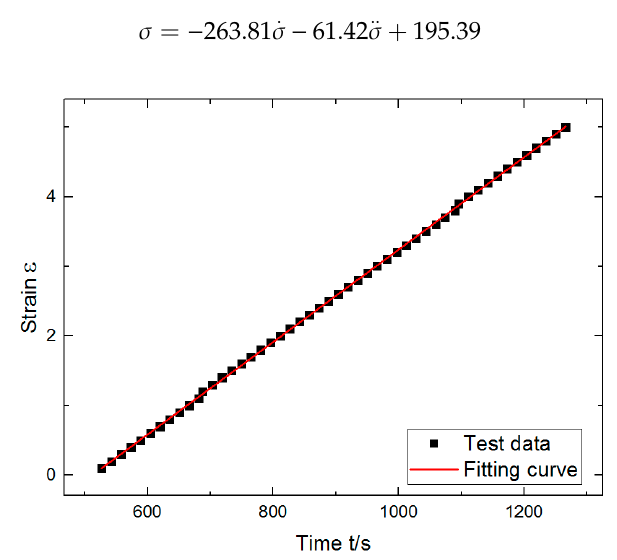
Figure 8. Strain time fitting curve.